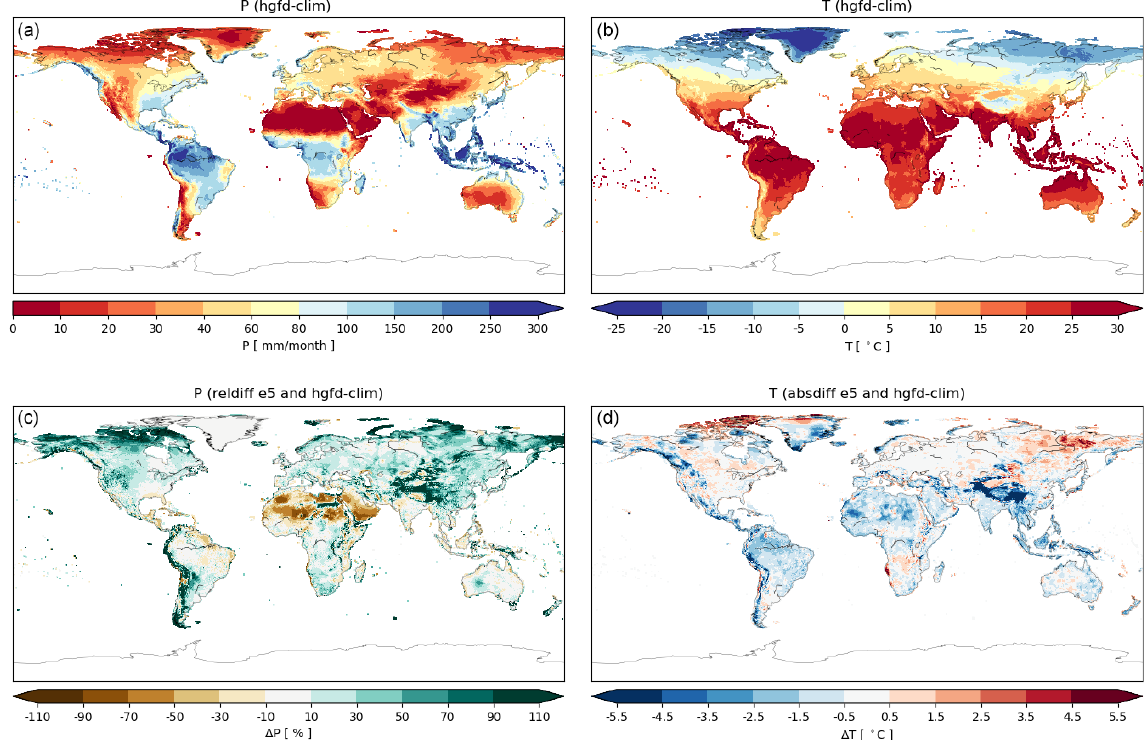
Figure 4. The baseline HydroGFD3 annual mean climatology for P (a) and T (b) . The bottom row shows the bias of the e5 reanalysis for each variable to the climatology. Note that the lack of P bias for e5 in Greenland is due to the definition of using e5 climatology for that